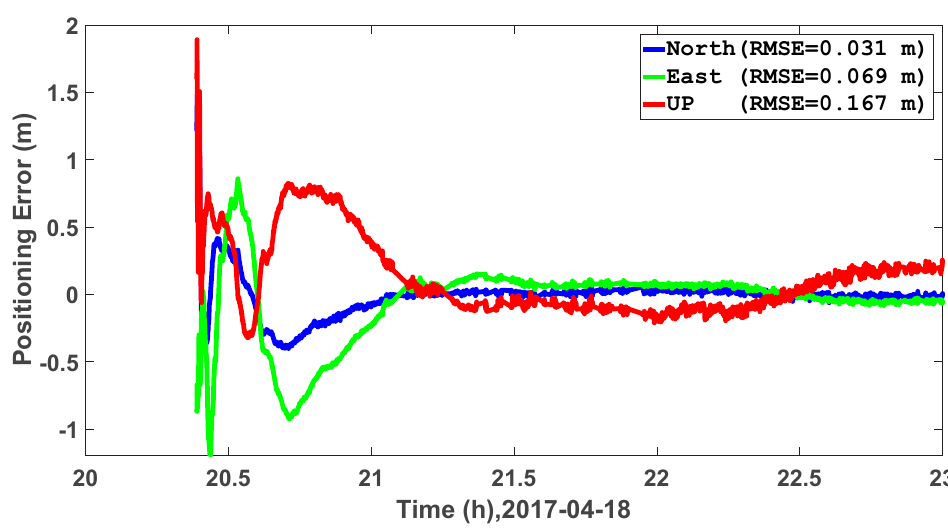
Figure 10. Kinematic PPP results around a children’s hospital in Calgary on 18 April 2017.